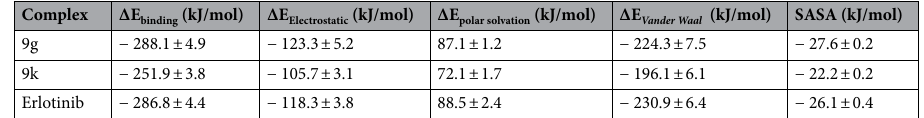
Table 5. The binding free energies of 9g , 9k and erlotinib in complex with EGFR.